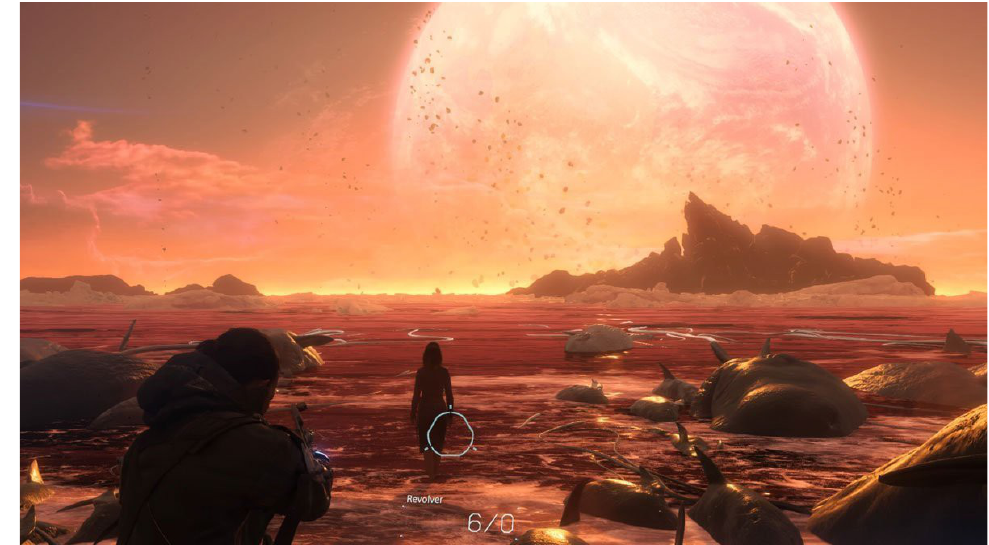
Figure 3. Sam and Amelie (in the form of an EE) on Amelie’s Beach.